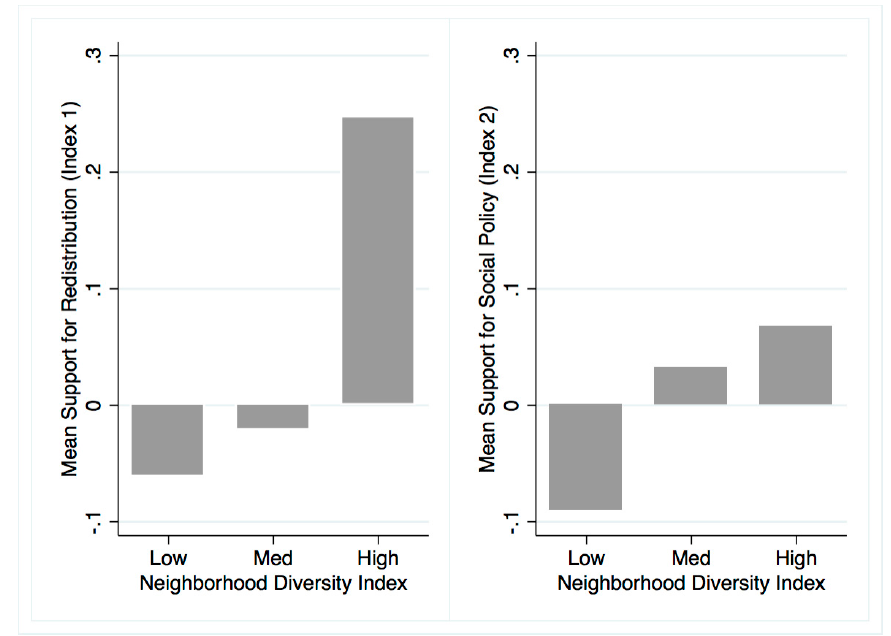
Figure 5. Mean support for redistribution and social policies by perceived neighborhood diversity.